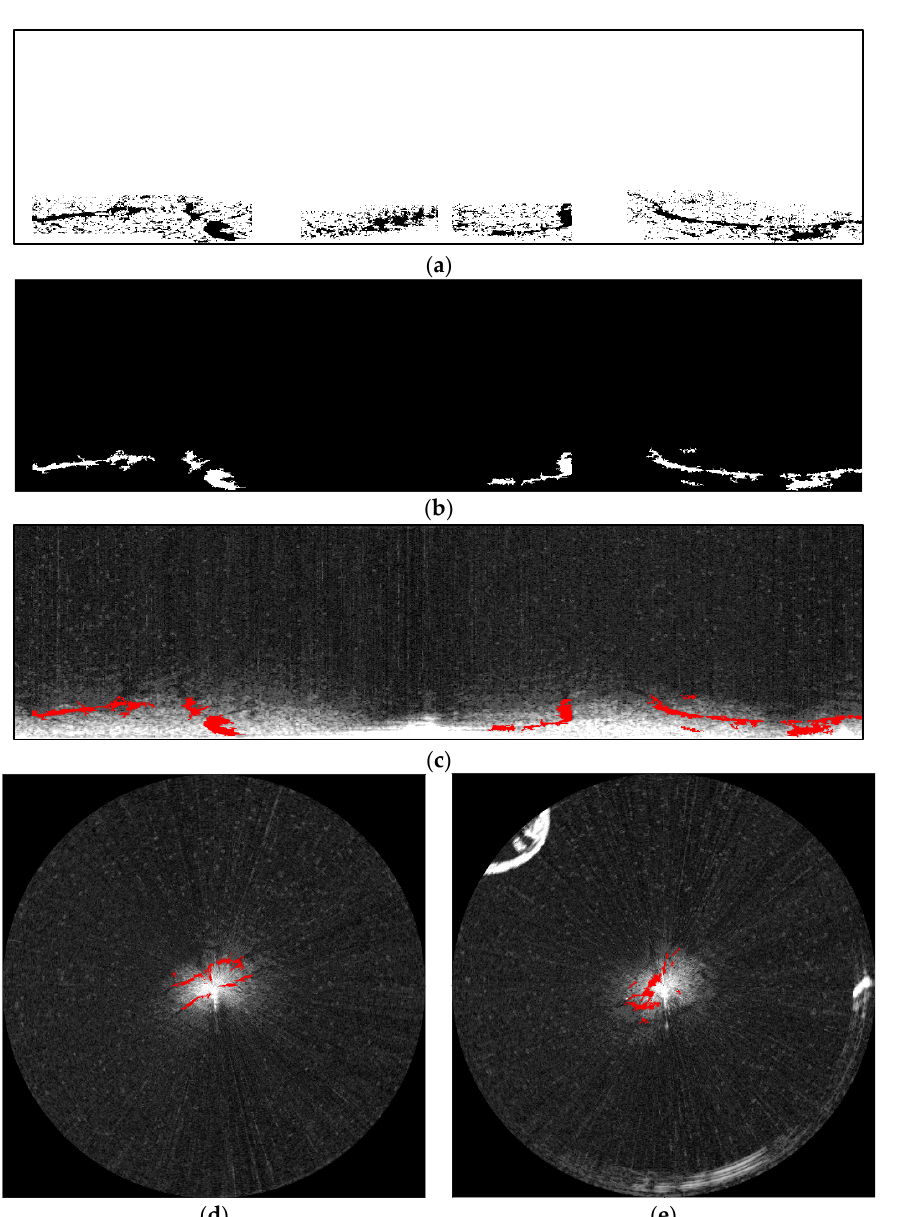
Figure 13. Oil spill precise identification. ( a ) The block noises were removed for the first time; ( b ) The block noises were removed for the second time in the flipped image; ( c ) Oil spill identification results in the Cartesian coordinate system. The red color targets were oil films, while ( d , e ) were oil spill identification results of Figure 1a,b in polar coordinate system,